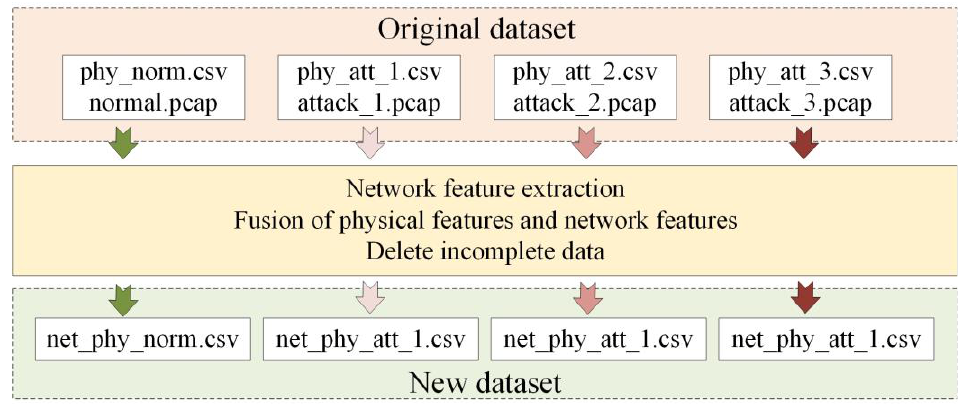
Figure 2. Changes of stage value and Tank_1 water level during process cycle.